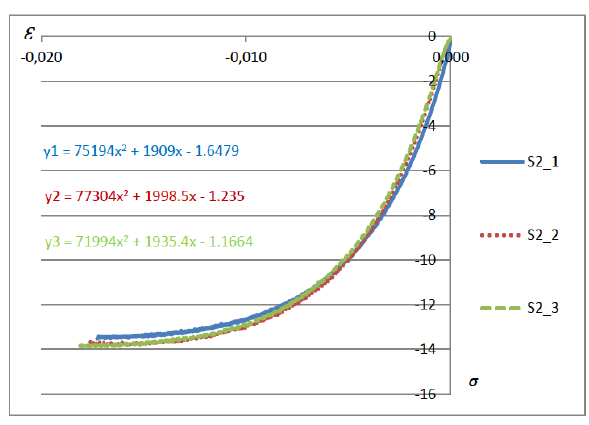
Figure 7: Dependence σ on C2S2 adhesive, three samples under compression